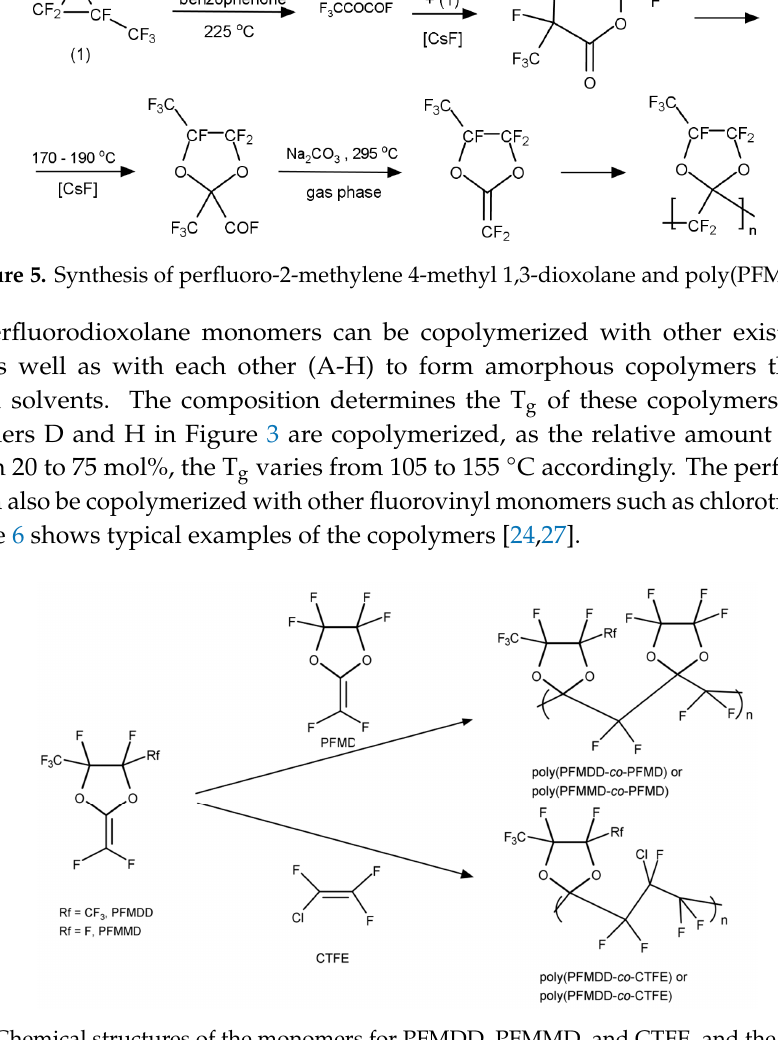
Figure 4. A typical synthetic route for a perfluorodioxolane monomer and the polymer. The case of poly(PFMMD) is shown.